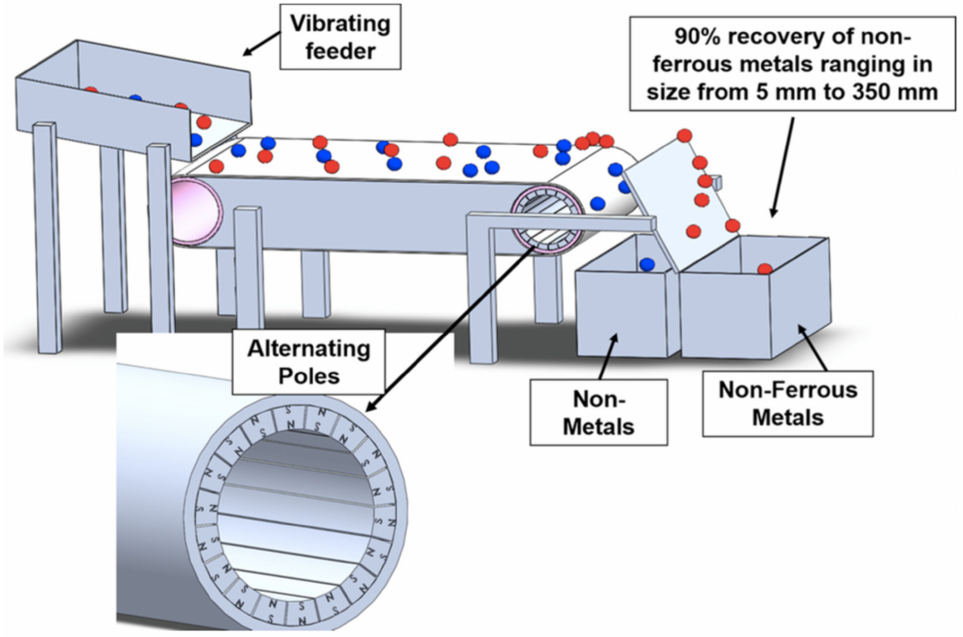
Figure 8. Description of a typical belt-driven rotary drum design of an eddy current